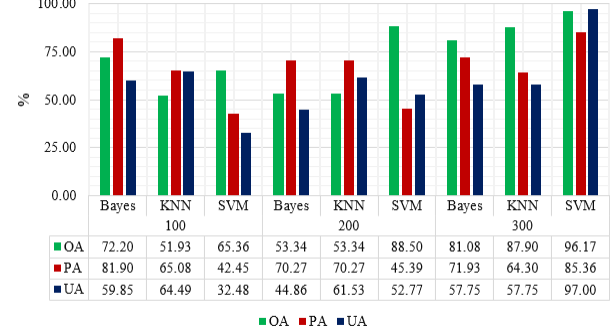
Fig. 7. Comparison of accuracy test based on TTA masks